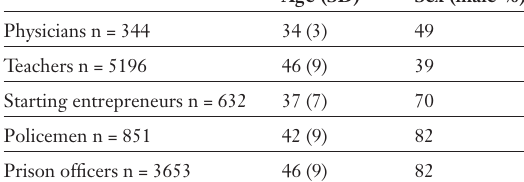
Sample description of the professions